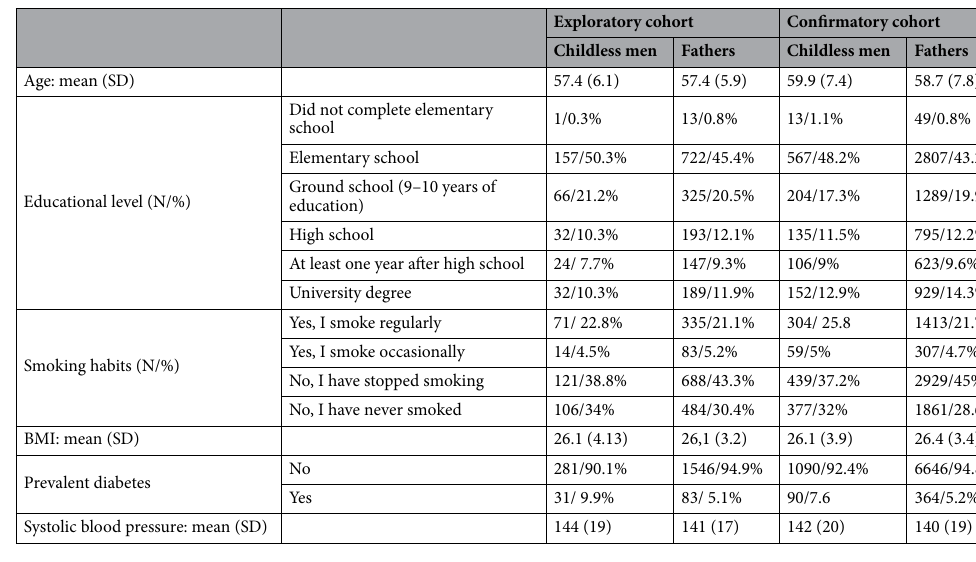
Table 1. Baseline characteristics of the participants in the exploratory and confirmatory cohorts.